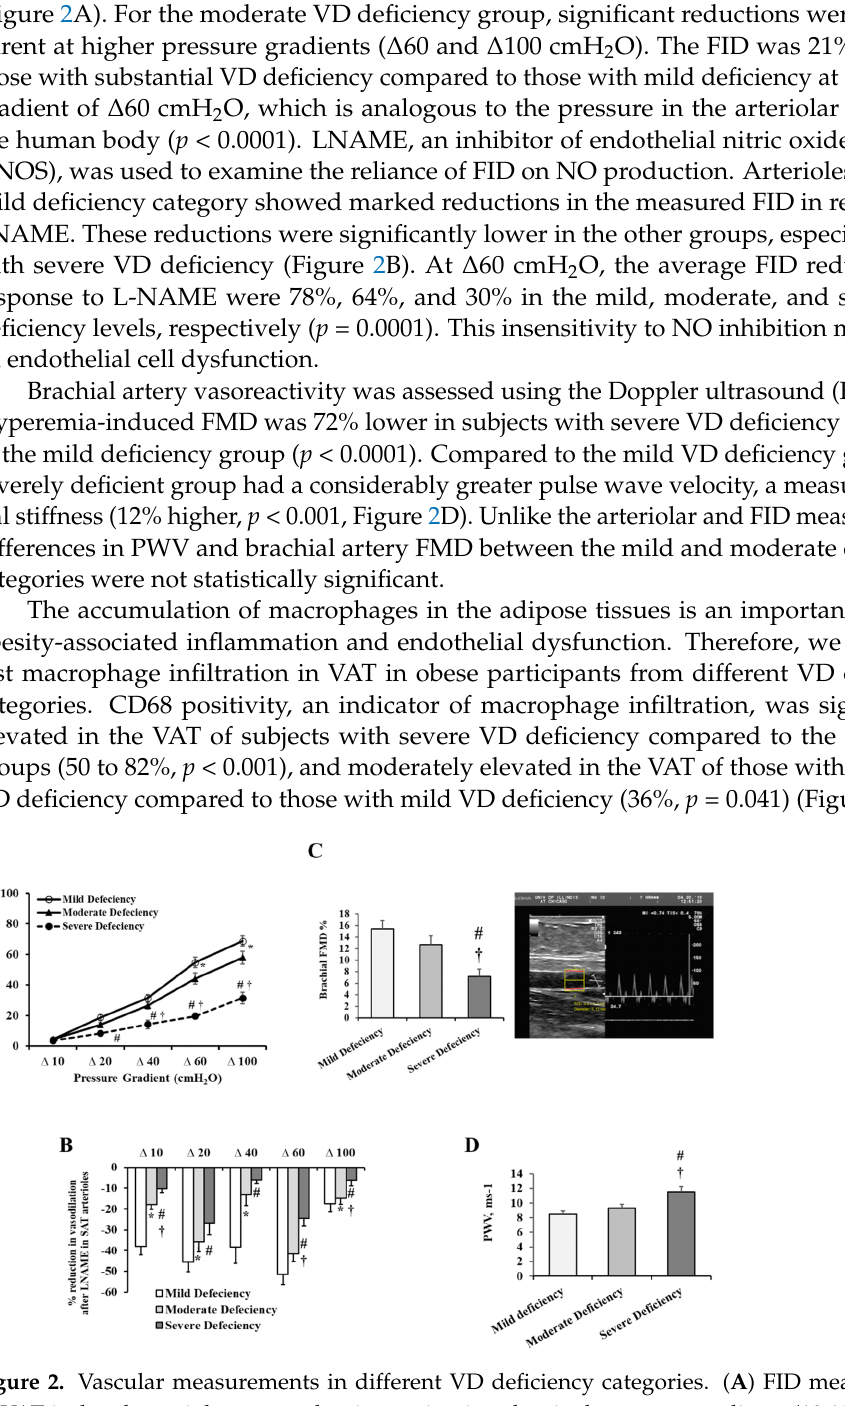
FID measurements, differences in PWV and brachial artery FMD between the mild and moderate deficiency categories were not statistically significant. The accumulation of macrophages in the adipose tissues is an important factor in obesity-associated inflammation and endothelial dysfunction. Therefore, we sought to test macrophage infiltration in VAT in obese participants from different VD deficiency categories. CD68 positivity, an indicator of macrophage infiltration, was significantly ele- vated in the VAT of subjects with severe VD deficiency compared to the other two groups (50 to 82%, p < 0.001), and moderately elevated in the VAT of those with moderate VD deficiency compared to those with mild VD deficiency (36%, p = 0.041) (Figure 3A,B). Vitamin D has an anti-inflammatory action and an association between VD defi- ciency and adipose tissue inflammation has been previously reported [32]. The enzyme CYP27B1 (1-alpha hydroxylase) produces the active form of VD, 1,25-dihydroxyvitamin D3, which exerts its effect by binding to the VD receptor (VDR). Therefore, in the present study, we determined the protein concentrations of CYP27B1 and VDR in VAT using Western blotting (Figure 3C,D). The severe VD deficiency group had 40% lower CYP27B1 protein levels than the moderate VD deficiency group ( p = 0.311), whereas there were no significant differences between the mild and moderate VD deficiency groups. On the other hand, the VDR protein levels increased from mild to moderate (38%) to severe (49%) VD deficiency categories in a dose-dependent manner ( p = 0.006).